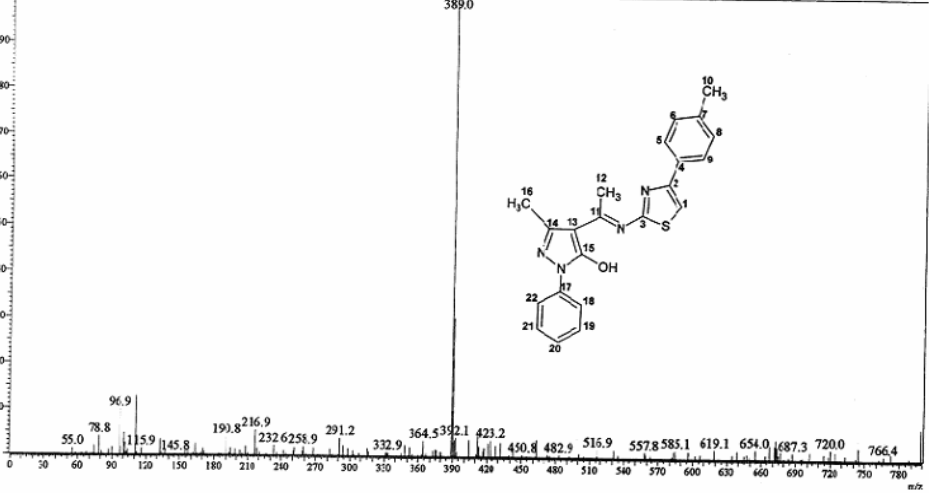
Figure 1. Mass Spectra of AcPMPAMPT